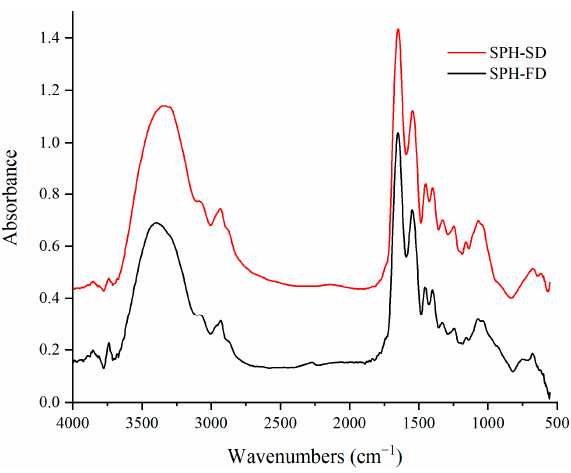
Figure 2. FTIR spectra of SPH-SD and SPH-FD.